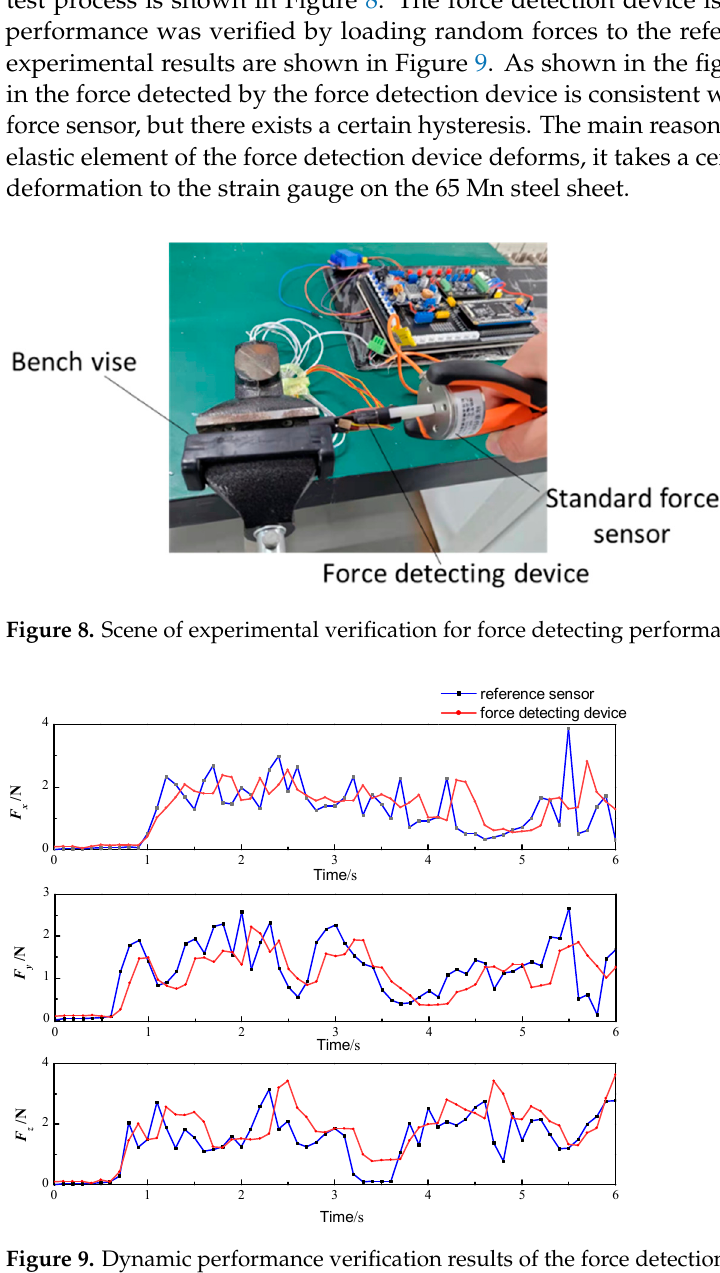
Figure 9. Dynamic performance verification results of the force detection device.